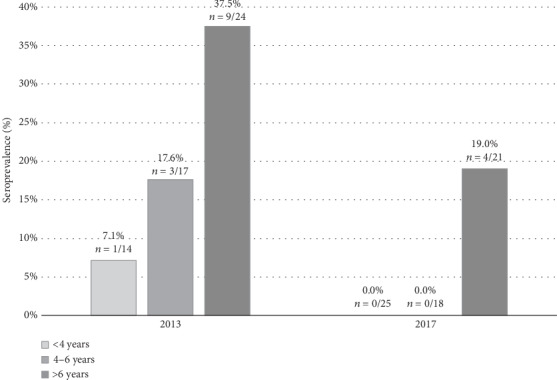
Canine seroprevalence values distributed in age classes (<4, 4-6, and >6 years) in 2013 (n = 55) and in 2017 (n = 64).